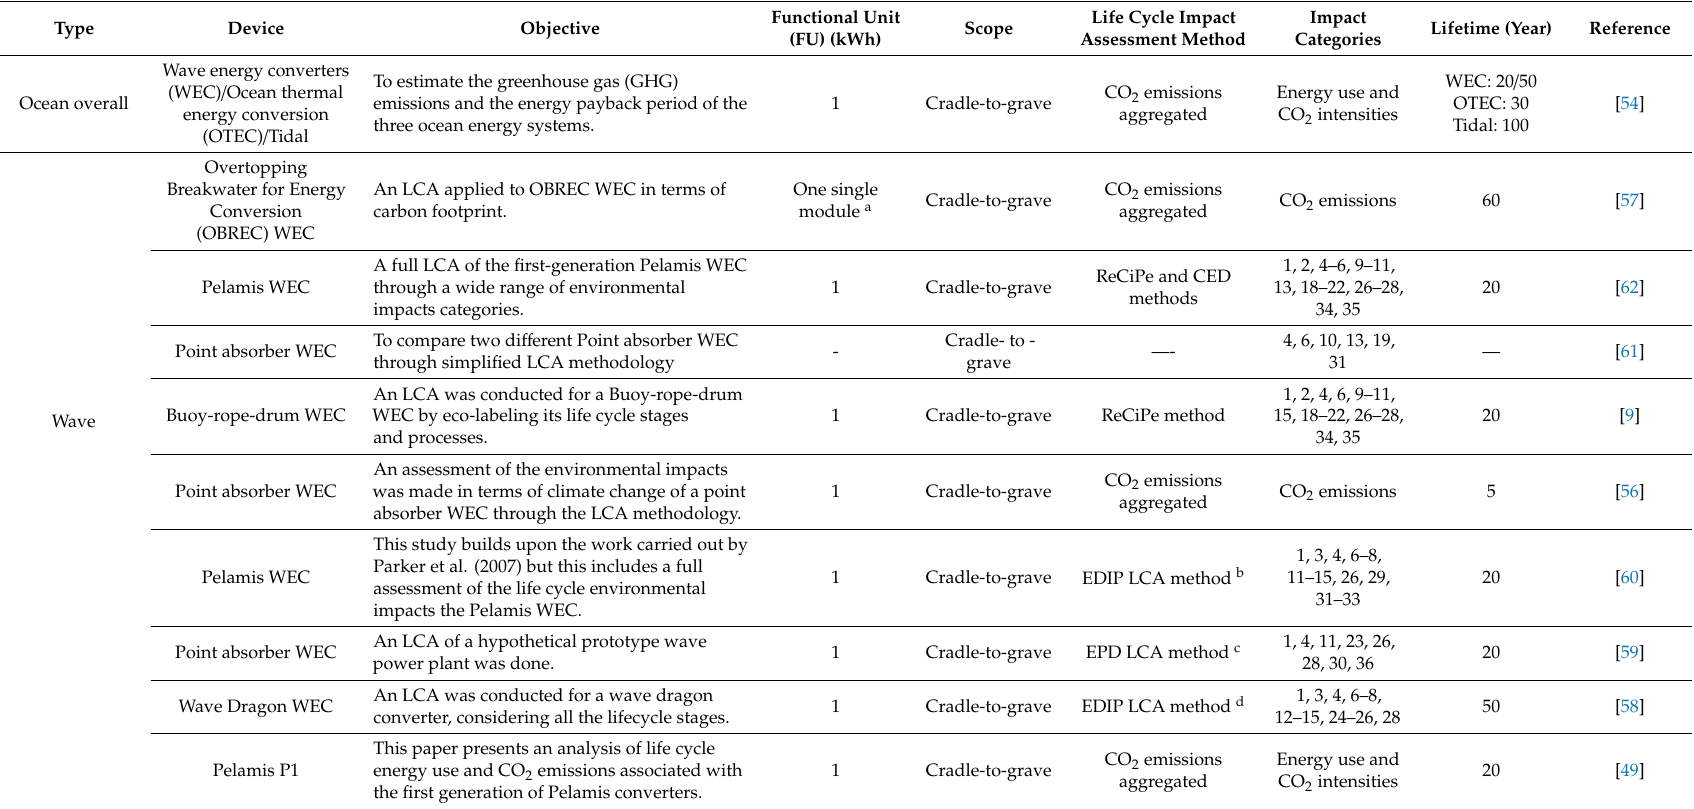
Table 1. LCA studies of ocean energy